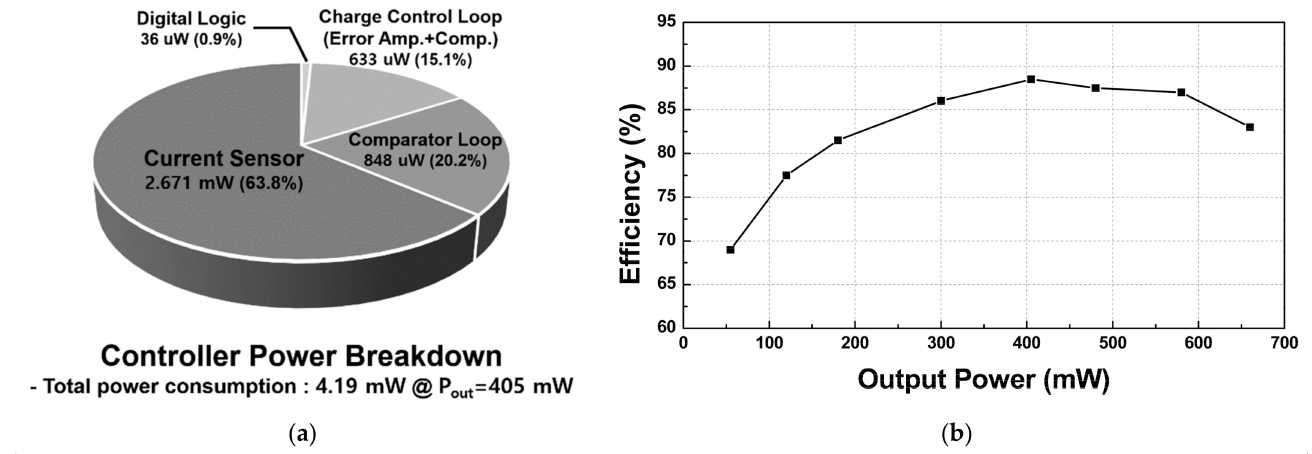
Figure 13. ( a ) Power consumption of the proposed SIMO DC-DC converter controller; ( b ) power conversion efficiency of the proposed SIMO DC-DC converter.